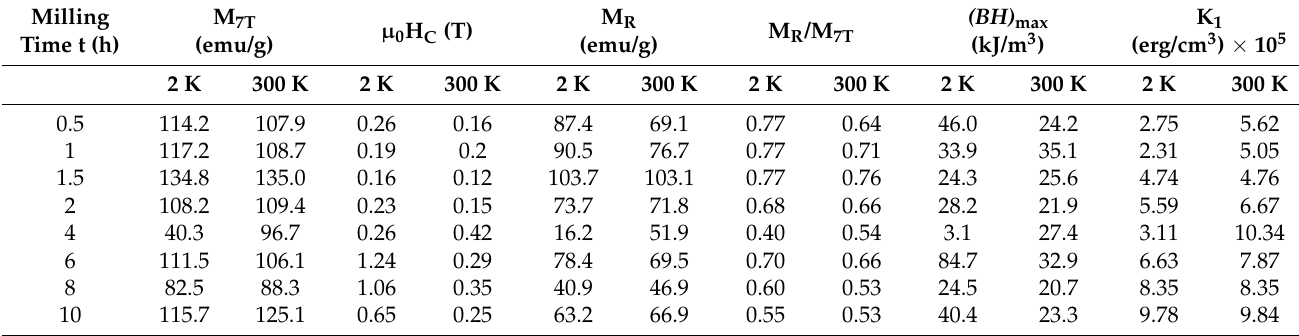
Table 2. Magnetic parameters for as-milled SmCo 5 / α -Fe (5%wt. of α -Fe)